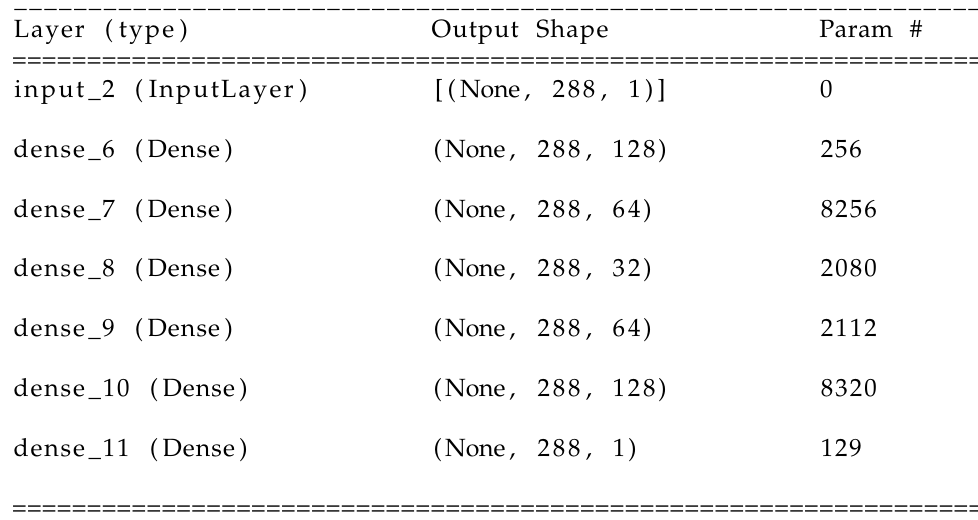
Figure 2. Specification for AE with dense